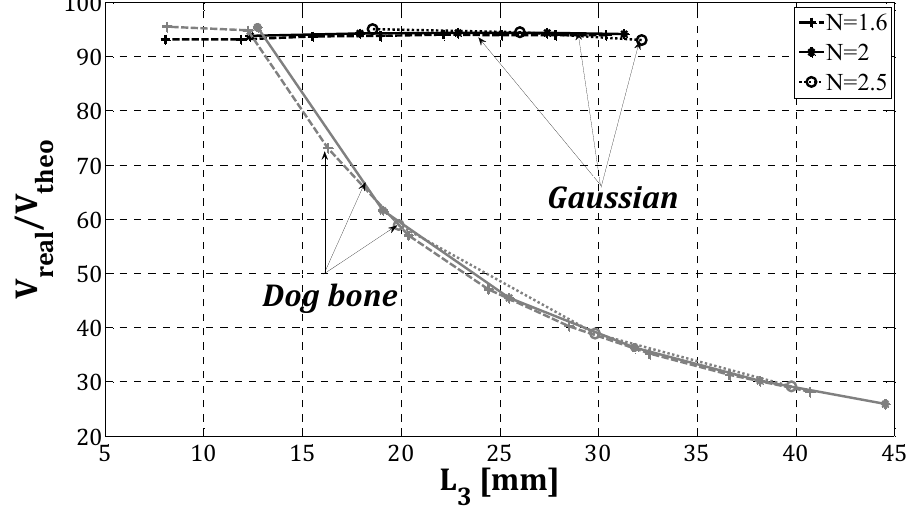
V V in dog-bone and Gaussian specimens with respect to the length Figure 4: Percent ratio / real theor